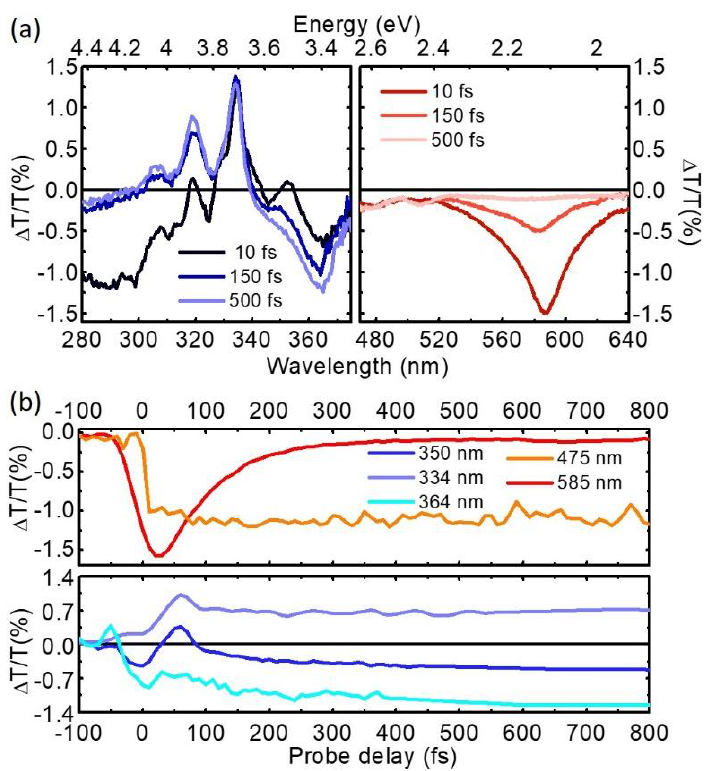
Figure 8. ( a ) TA spectra of pyrene following excitation at 340 nm at different probe delays; ( b ) TA dynamics at probe wavelengths in the UV and visible range. For ease of comparison, the traces at 475 and 334 nm have been multiplied by a factor 10 and 0.5 respectively.